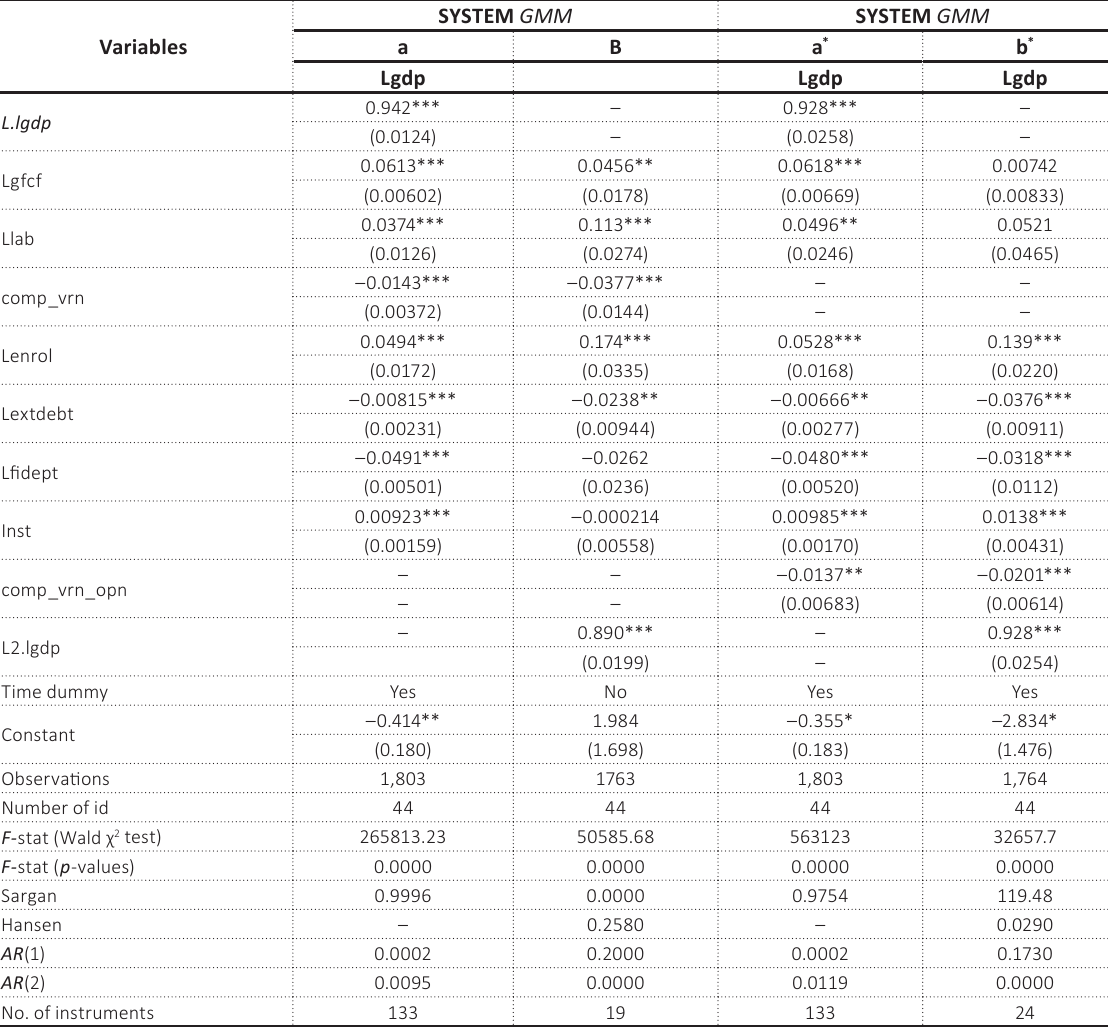
Source: Computed using Stata